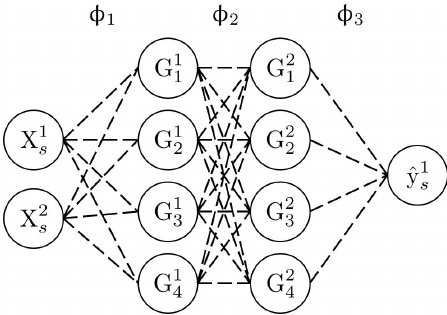
Figure 5. Structure of a neural network. Figure 4. Structure of a neural network. composed of four neurons. The input neurons on the left are associated with the input data 229 (labelled X d s ), whereas the output neuron on the right is associated with the output data 230 (labelled y 1 s ). The value of a neuron on the intermediate layers is determined by carrying the 231 linear combinations of the connected neurons from the previous layer and then applying 232 an activation function ((Eq. 9)). b